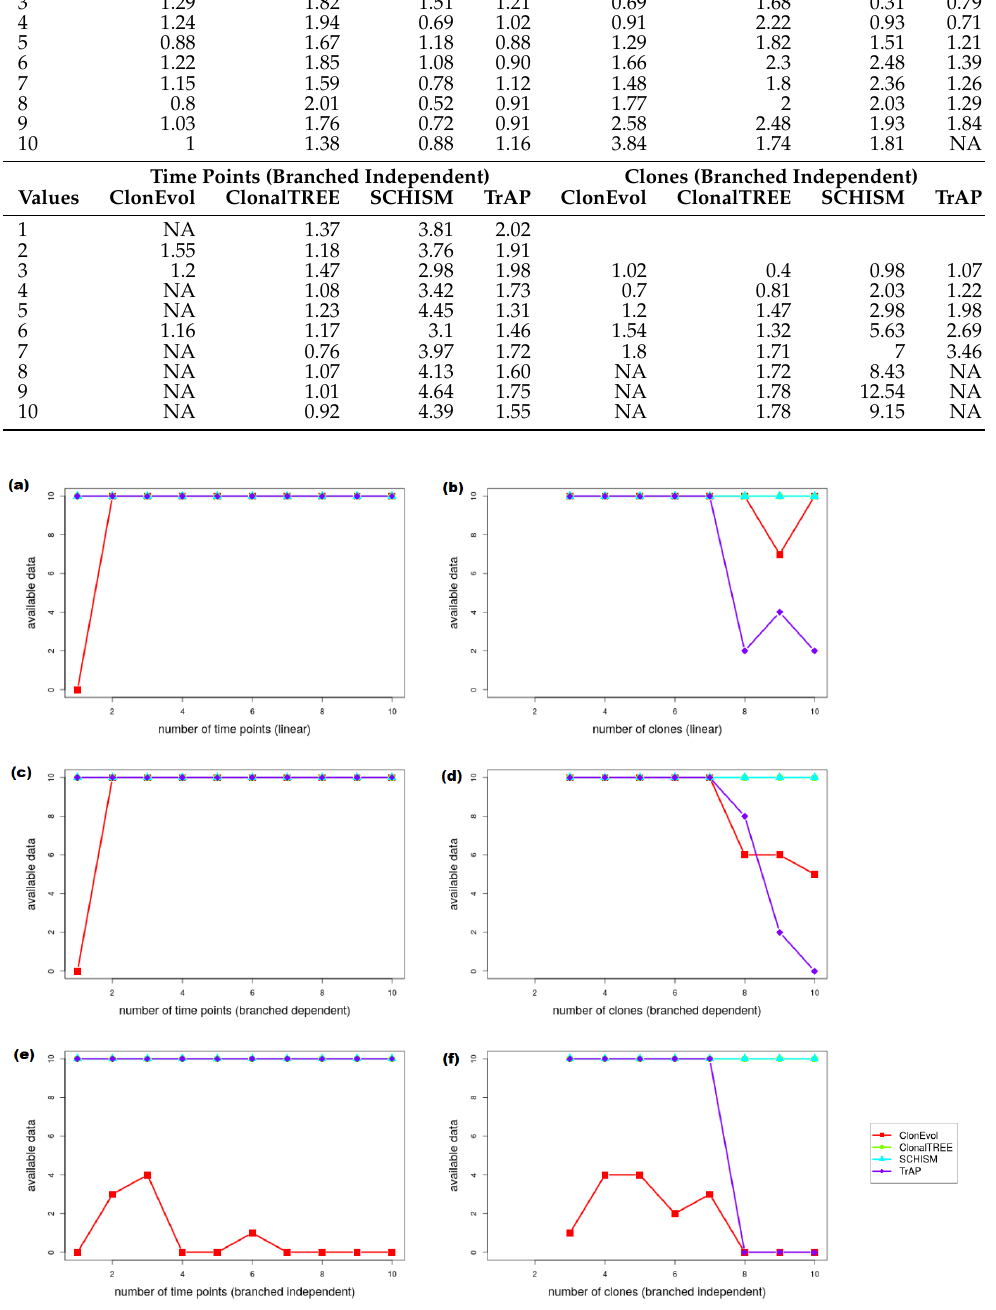
Figure A14. Available tree output generated using ClonEvol, ClonalTREE, SCHISM, and TrAP. For each considered number of time points and clones under the models of clonal evolution linear, branched dependent, and branched independent, 10 patients were simulated; ( a ) linear evolution, varying number of time points, ( b ) linear evolution, varying number of clones, ( c ) branched dependent evolution, varying number of time points, ( d ) branched dependent evolution, varying number of clones, ( e ) branched independent evolution, varying number of time points, and ( f ) branched independent evolution, varying number of